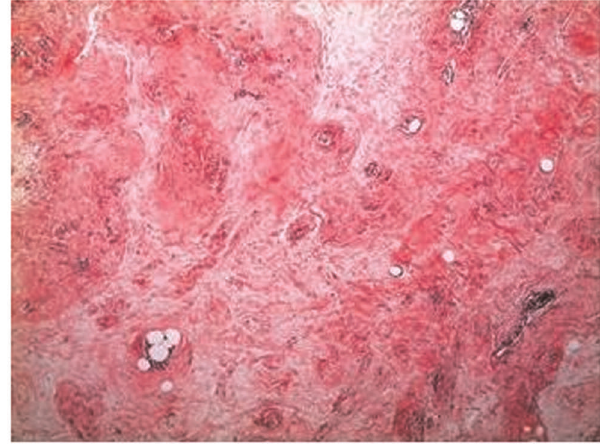
Figure 3 - Pseudo-angiomatous hyperplasia, (H&E), 6 40.